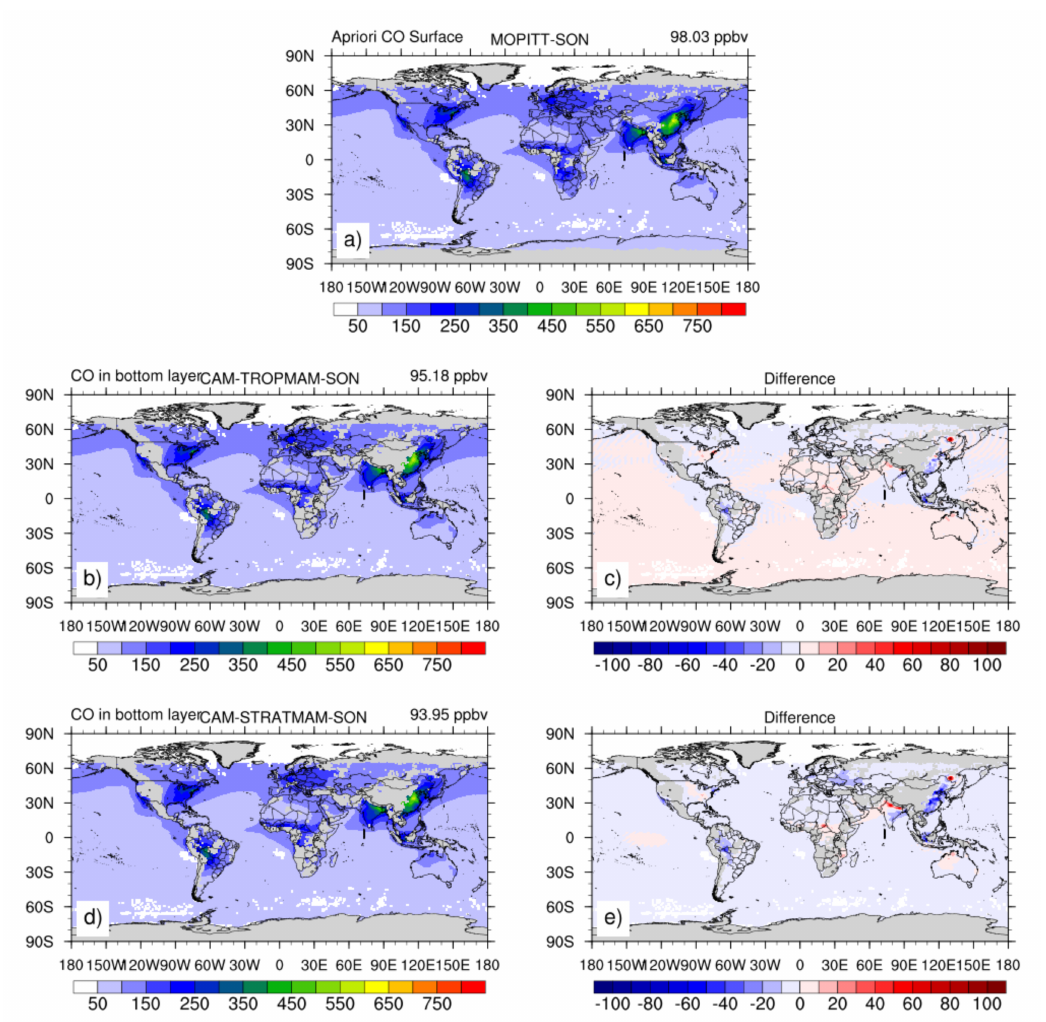
Figure 4. ( a ) CO (ppb) observed by MOPITT sensor for September-October-November (SON), in the period of 2010–2014, ( b ) CO simulated by the CAM5-MAM3 model using tropospheric chemistry and ( d ) tropospheric/stratospheric chemistry mechanisms using the calculations of Equation (4). The right side of the figure shows the model difference minus the observation (MOPITT), ( c ) for tropospheric chemistry and ( e ) for tropospheric/stratospheric